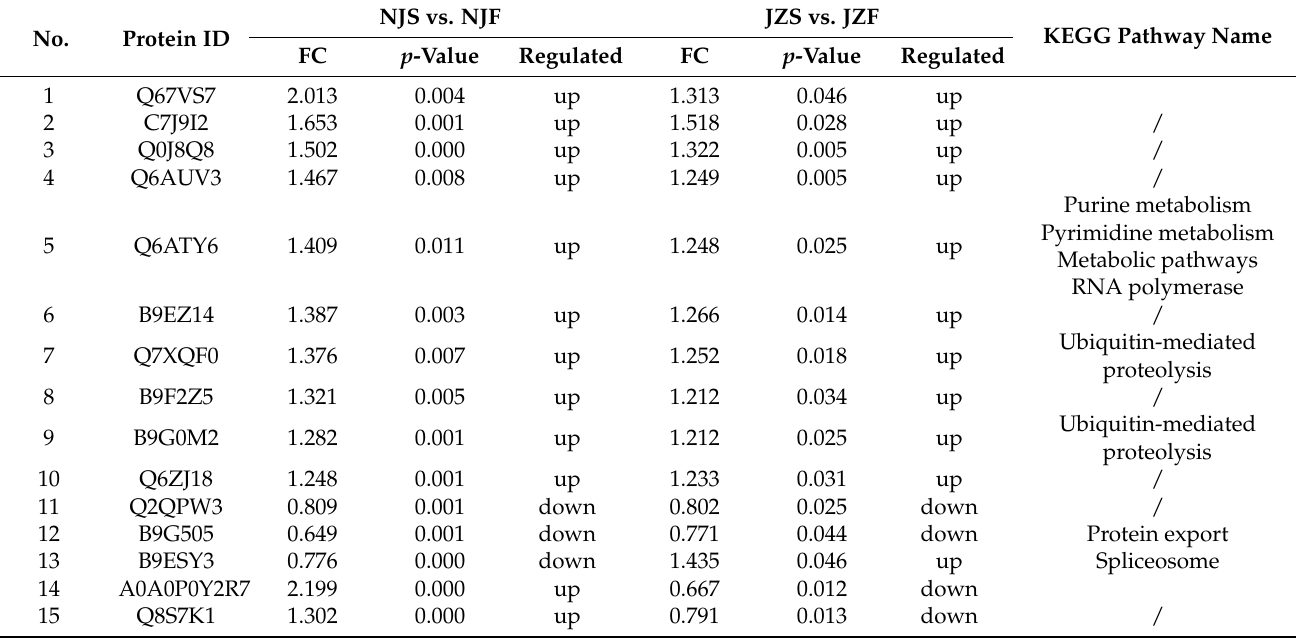
Table 2. Common DEPs of two varieties.